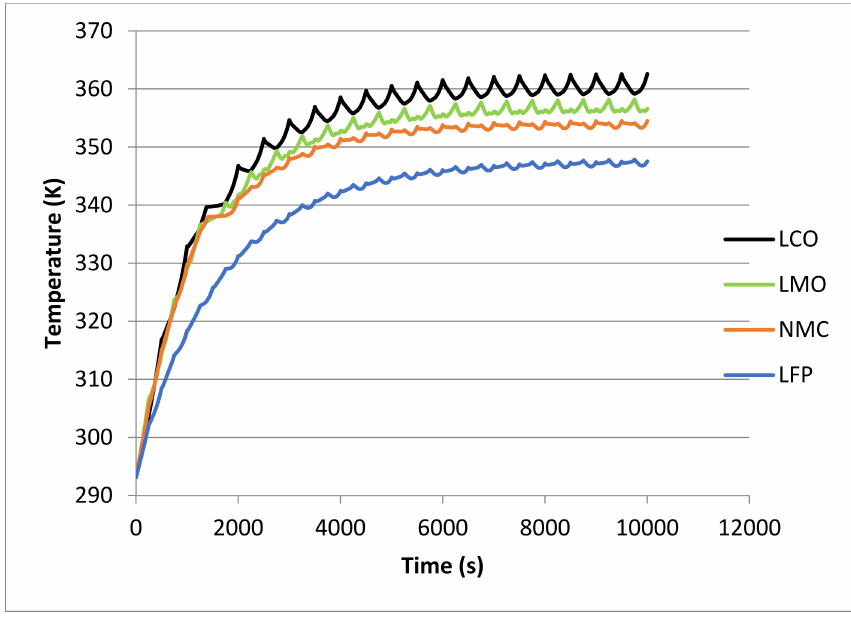
Figure 13. Temperature profiles as a function of time (h = 10 W/m 2 K). As might be expected, it is apparent that a lower temperature of the external environ- ment will improve the thermal stability of the cells [75], increasing the thermal runaway ignition time and preventing it already for h < 8 W/m 2 K for all cells at 273 K (for the LFP cell, even less than 6 W/m 2 K is enough for a stable operation). This agrees well with the results obtained from oven tests by Lopez et al. [77] for an LCO